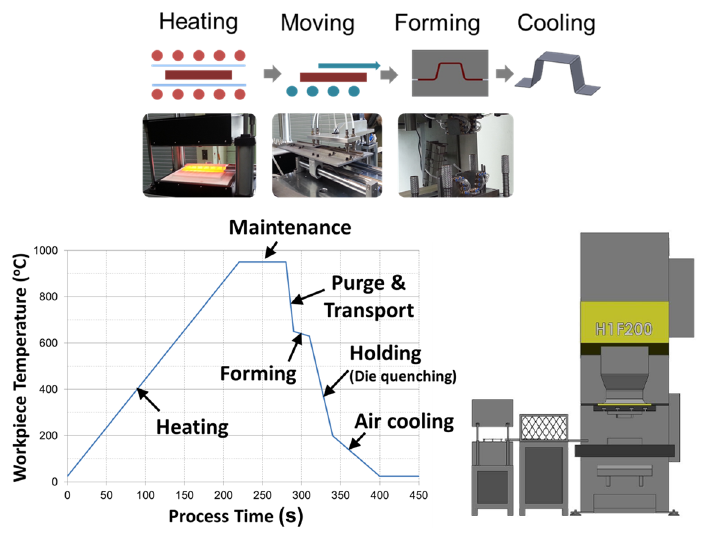
Figure 2. Schematic of hot stamping process and schematic time-temperature profile of the hot stamping process for the hat-type product.